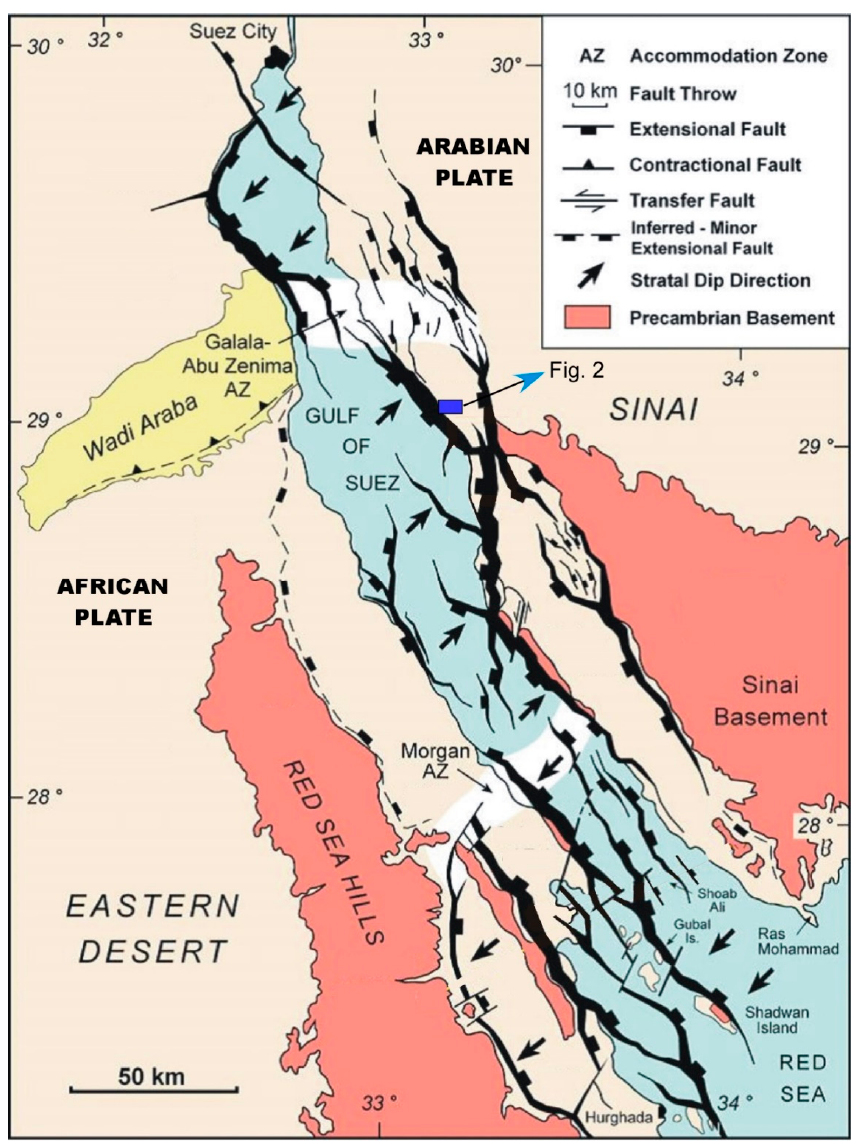
Figure 1. A general structural map showing the major faults and the dip polarity along the Gulf of Suez (GOS) Rift. The general stratal dip direction in the northern, southern, and central provinces change from SW to NE and back to SW, respectively, across the Galala-Abu Zenima and Morgan accommodation zones (modified after Bosworth, 2015 [11]). Location of the study area is shown by the small blue rectangle labeled Figure 2.